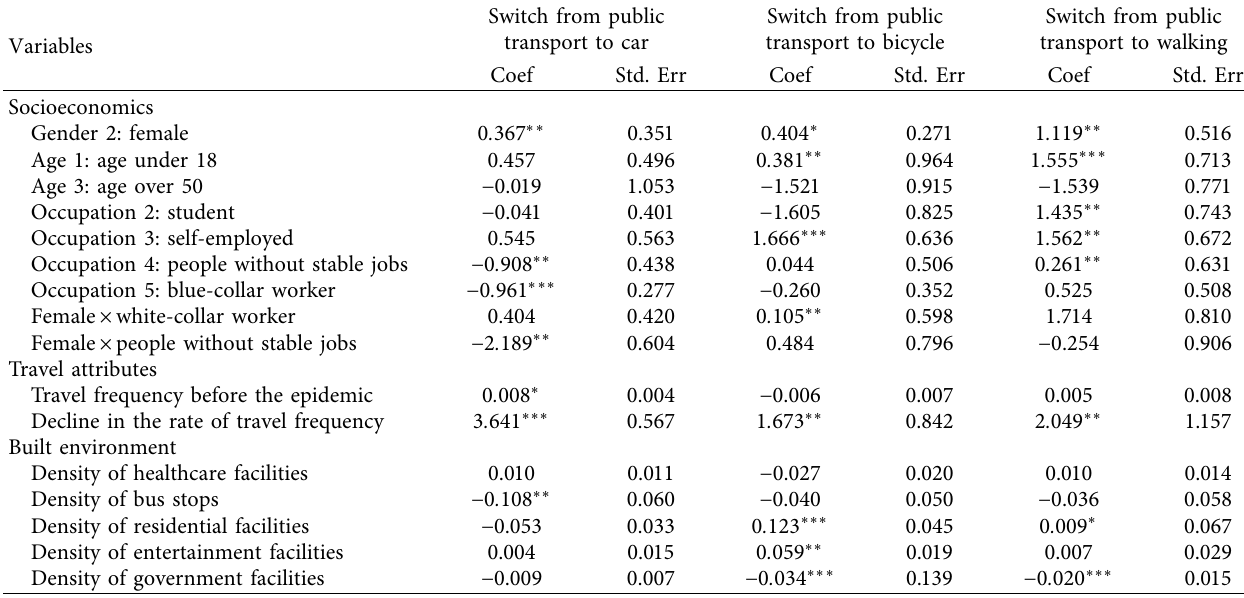
Table 3: Estimation results of determinants of switching from public transport to other modes.